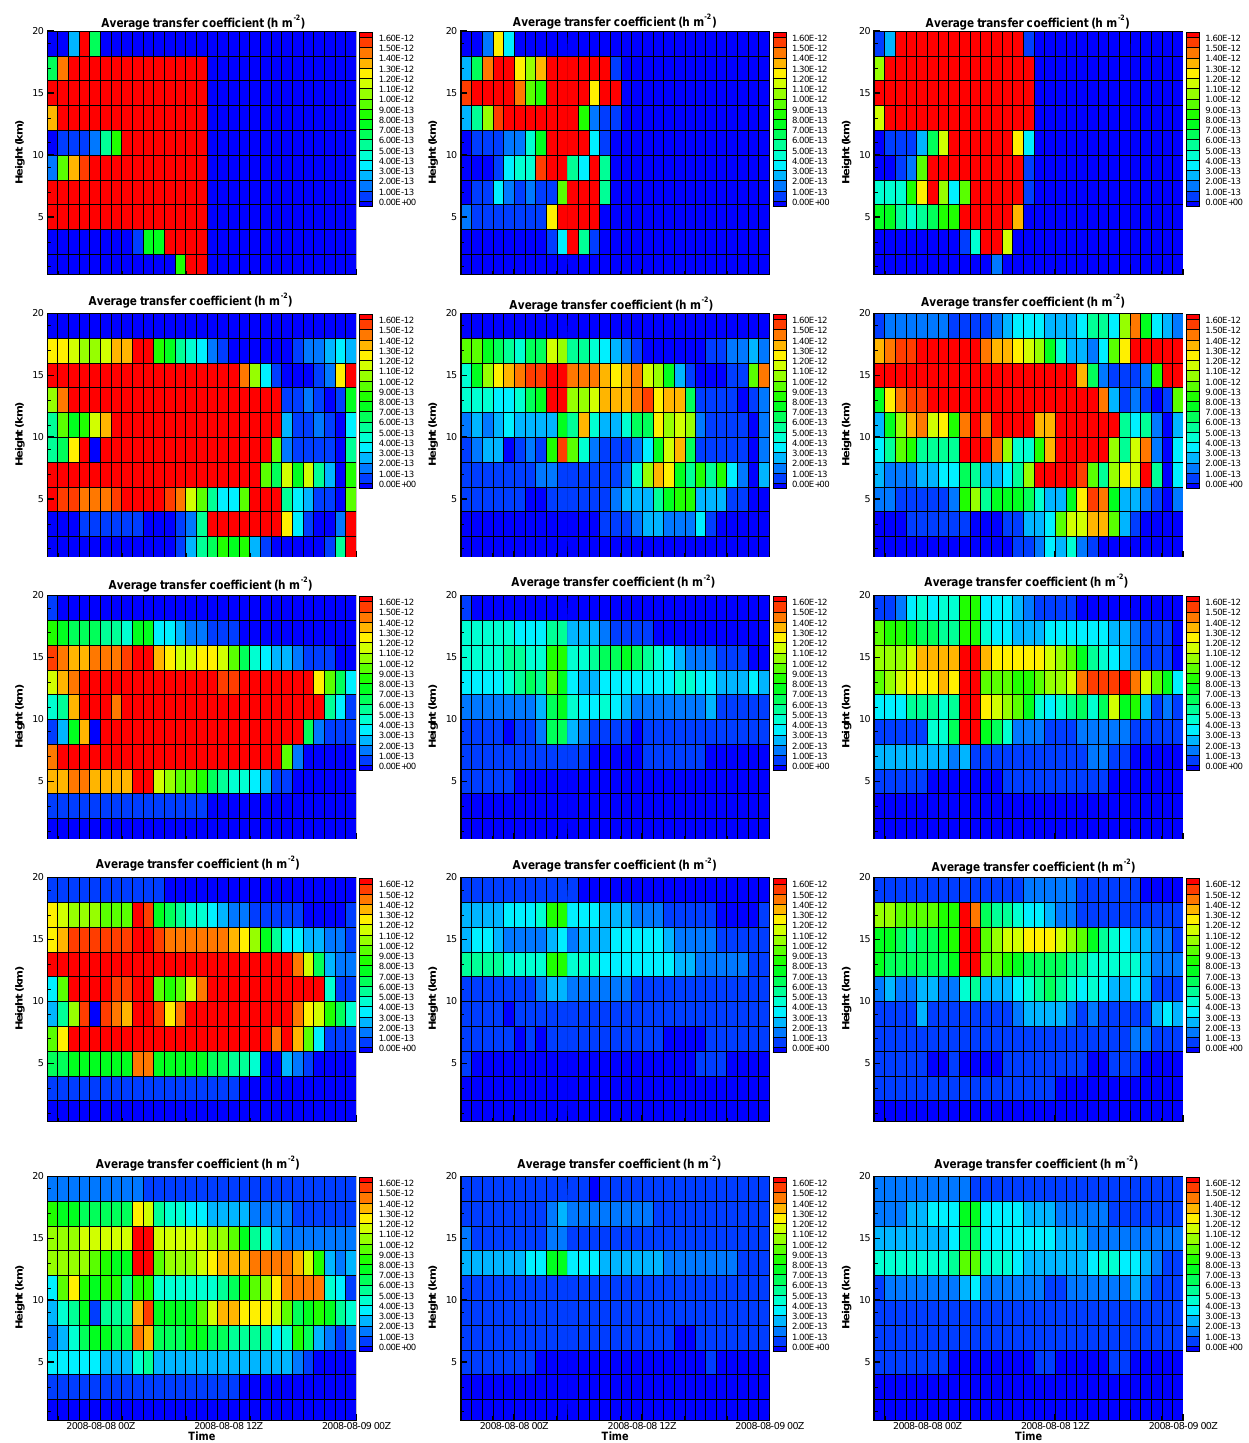
Figure 2. Averaged TCMs using GDAS meteorological data with three different options for calculating the model mass loadings (column 1, integrating from the surface to the observed cloud top; column 2, calculated for a single layer where the observed cloud top height resides; column 3, integrating over three layers centered at the observed cloud top layer). Rows 1–5 (from top to bottom) correspond to observations